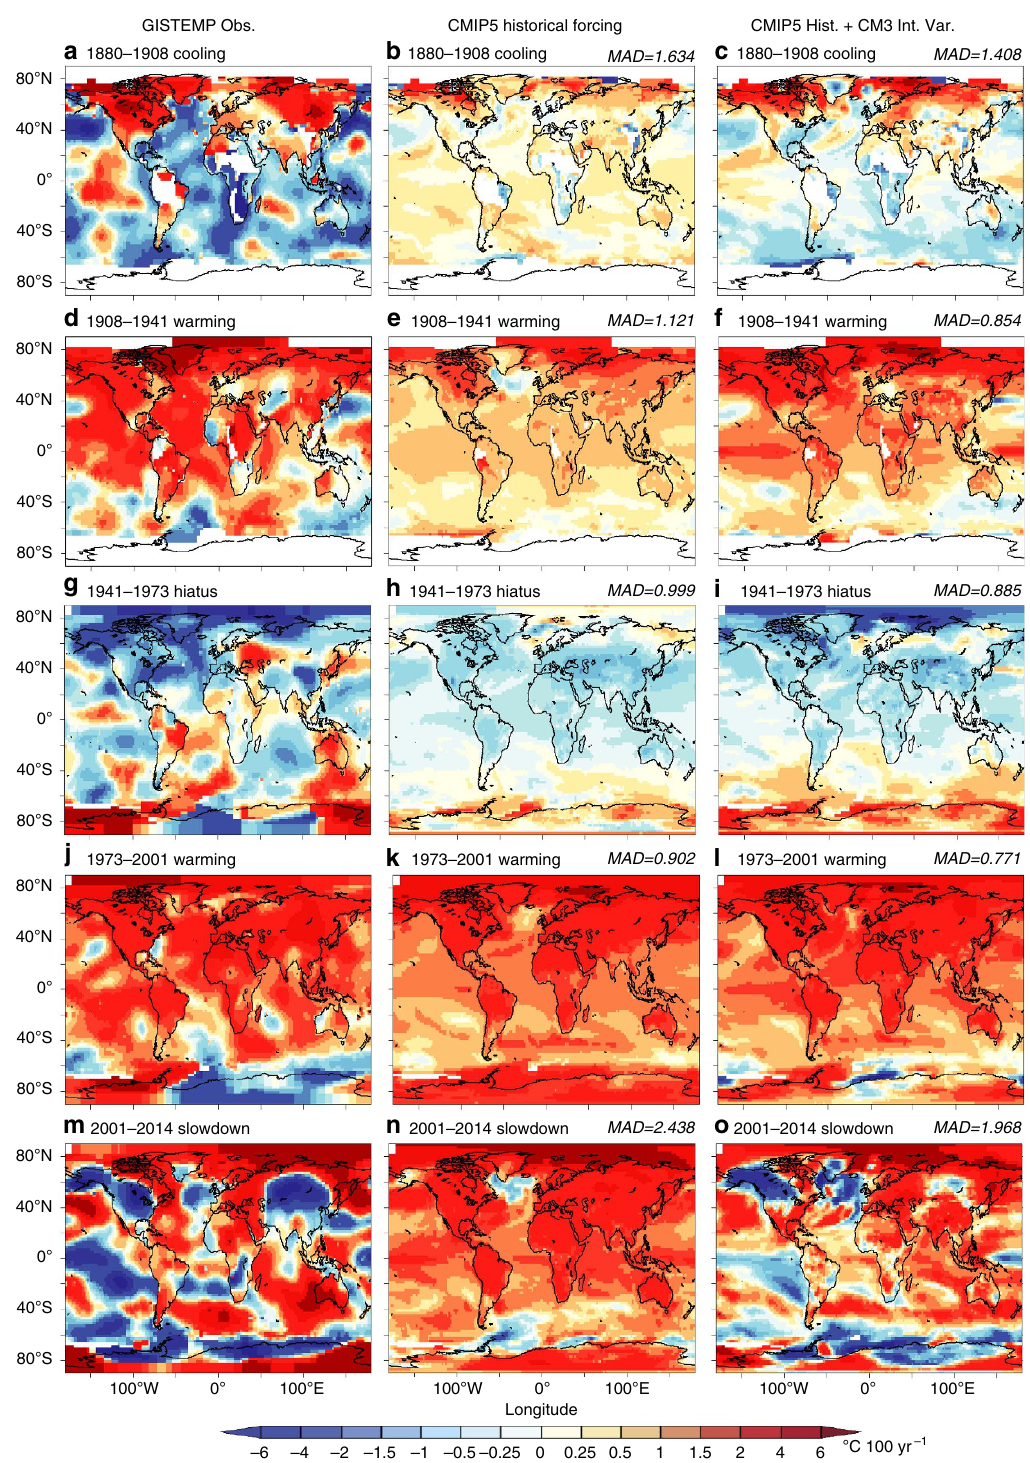
Figure 6 | Maps of observed and simulated surface temperature trends for five epochs. GISTEMP observed trends ( a , d , g , j and m ); CMIP5 ensemble All- Forcing trends ( b , e , h , k and n ); and CMIP5 All-Forcing ensemble plus CM3 control run trends based on selected multidecadal cooling/warming events in CM3 ( c , f , i , l and o ). For ( c , f , i , l and o ), the 10 CM3 control run events that result in the smallest globally averaged mean absolute deviation (MAD) of the trend map compared with the observed trends ( a , d , g , j and m ) were composited. The MAD of each modelled map versus the observed trend map is listed above each simulation panel (unit: (cid:2) C 100 yr (cid:2) 1 ) for the CMIP5 historical forcing only and for the CMIP5 trend combined with CM3 internal variability. The five epochs (year ranges) examined include: ( a – c ) Late 1880s cooling (1880–1908); ( d – f ) Early 20th century warming (1908–1941); ( g – i ) Mid-20th century hiatus (1941–1973); ( j – l ) Late 20th century warming (1973–2001); and ( m – o ) Early 21st century warming slowdown (2001–2014). Model results are based on combined SST/surface air temperature data, with the observed missing data mask applied to model data. Grid boxes where o 33% of months have observed data available for the trend period were masked out of the trend maps (denoted by white